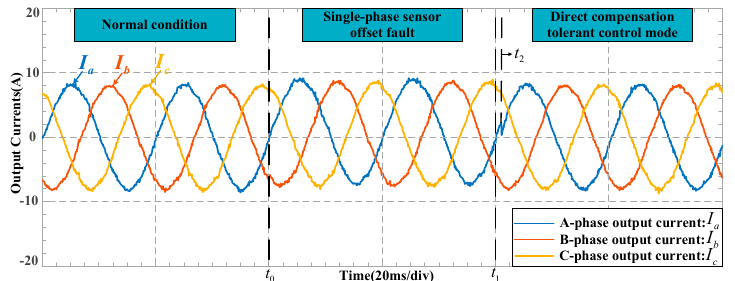
Figure 10. Experimental results for single − phase sensor offset fault using direct compensation tolerant control mode.